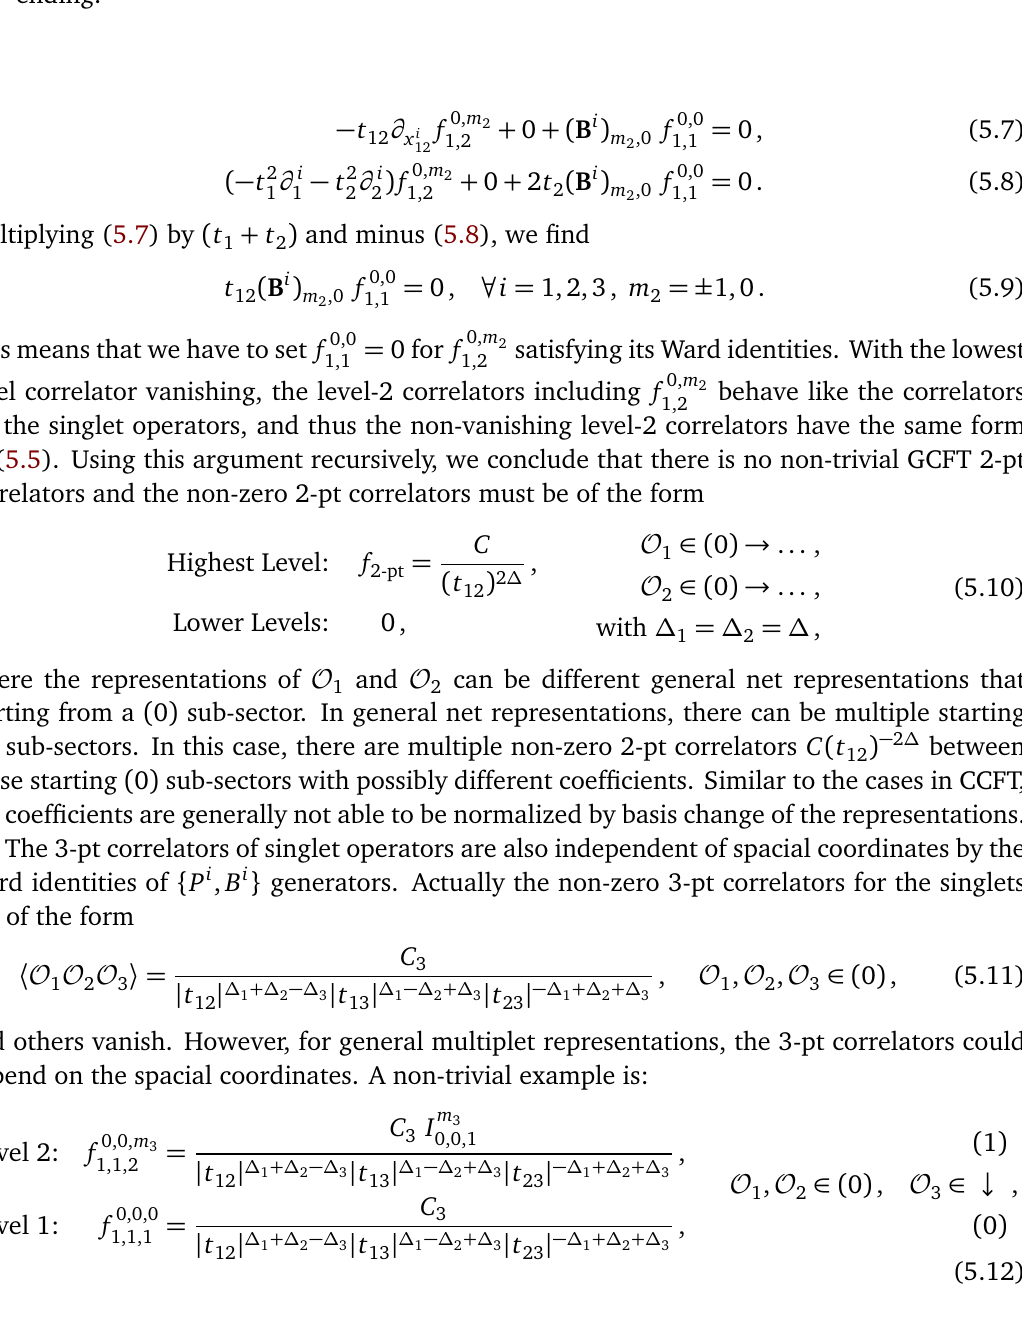
Figure 13: An example with two ending ( 0 ) sub-sectors (red ones), and there is only one ( 1 ) sub-sector links to each one. Noticing the middle ( 0 ) sub-sector is not an